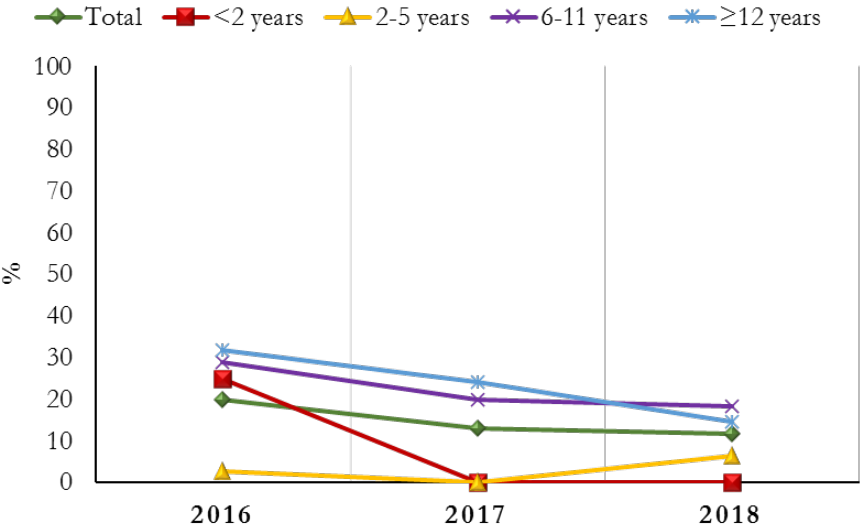
Figure 2. Subjects (%) treated with PPIs during the study period, stratified by age group.